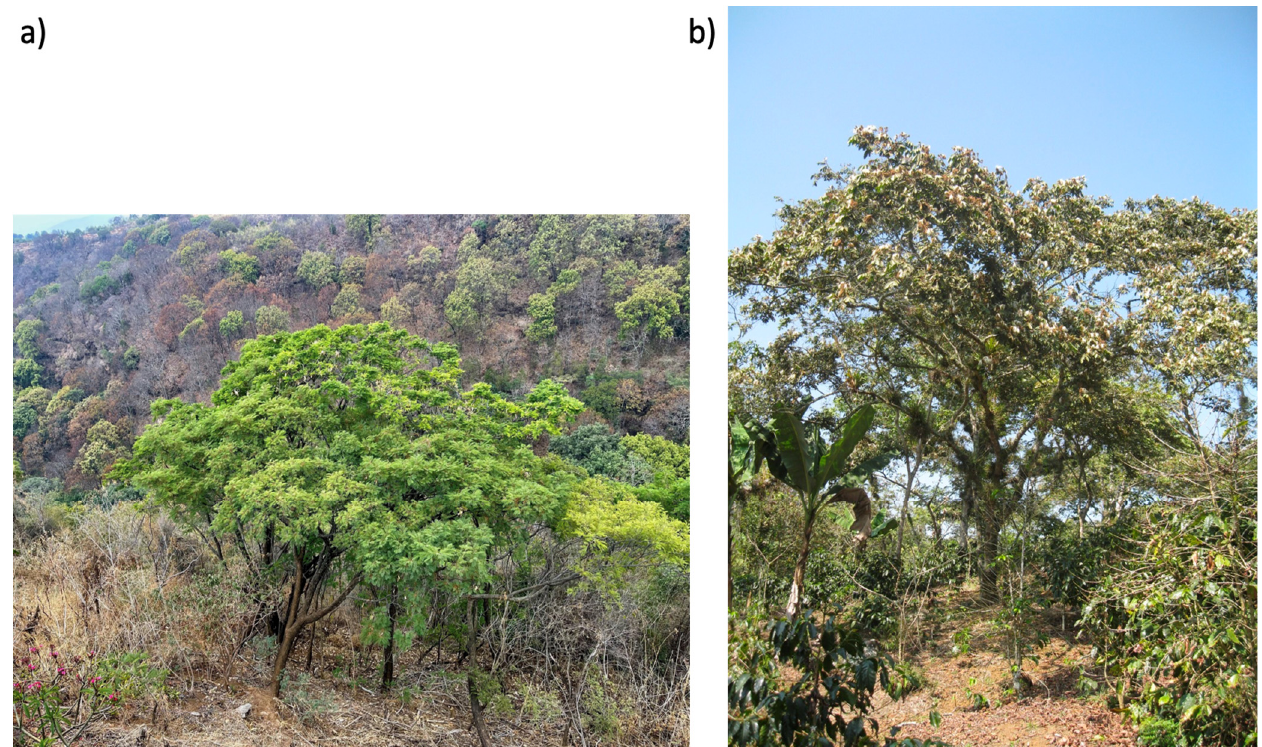
Figure 1. ( a ) Lysiloma sp. sampling site at Barranca del Tecolote Cuernavaca, Morelos, Mexico. ( b ) Inga vera sampling site in coffee plantations in San Marcos de León, Municipio de Xico, Veracruz, Mexico.